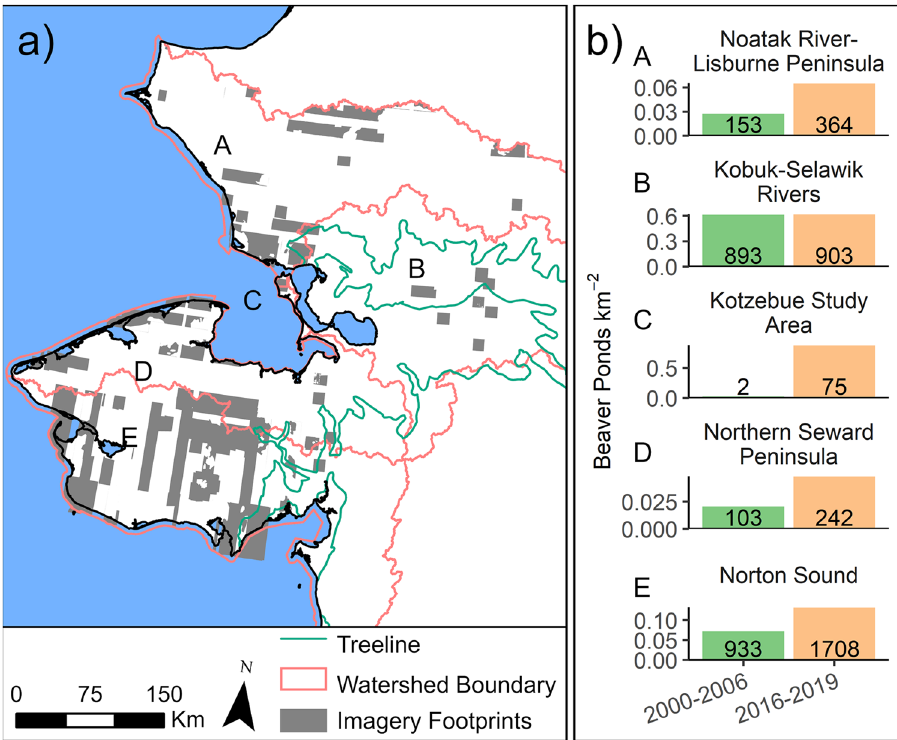
Figure 3. Beaver pond increases in western Alaska, ~ 2003 to ~ 2017. Shaded rectilinear areas indicate the areas assessed, where overlapping high-resolution satellite images were available at both timesteps. Red lines demarcate subareas keyed to graphs at right (area C is smaller and refers to results from a previous study 26 ).